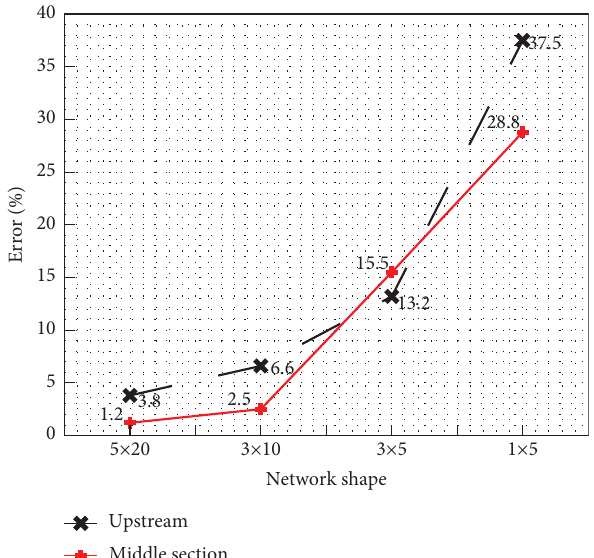
Figure 7: Network shapes and exudation point prediction errors obtained with upstream data and middle section data.